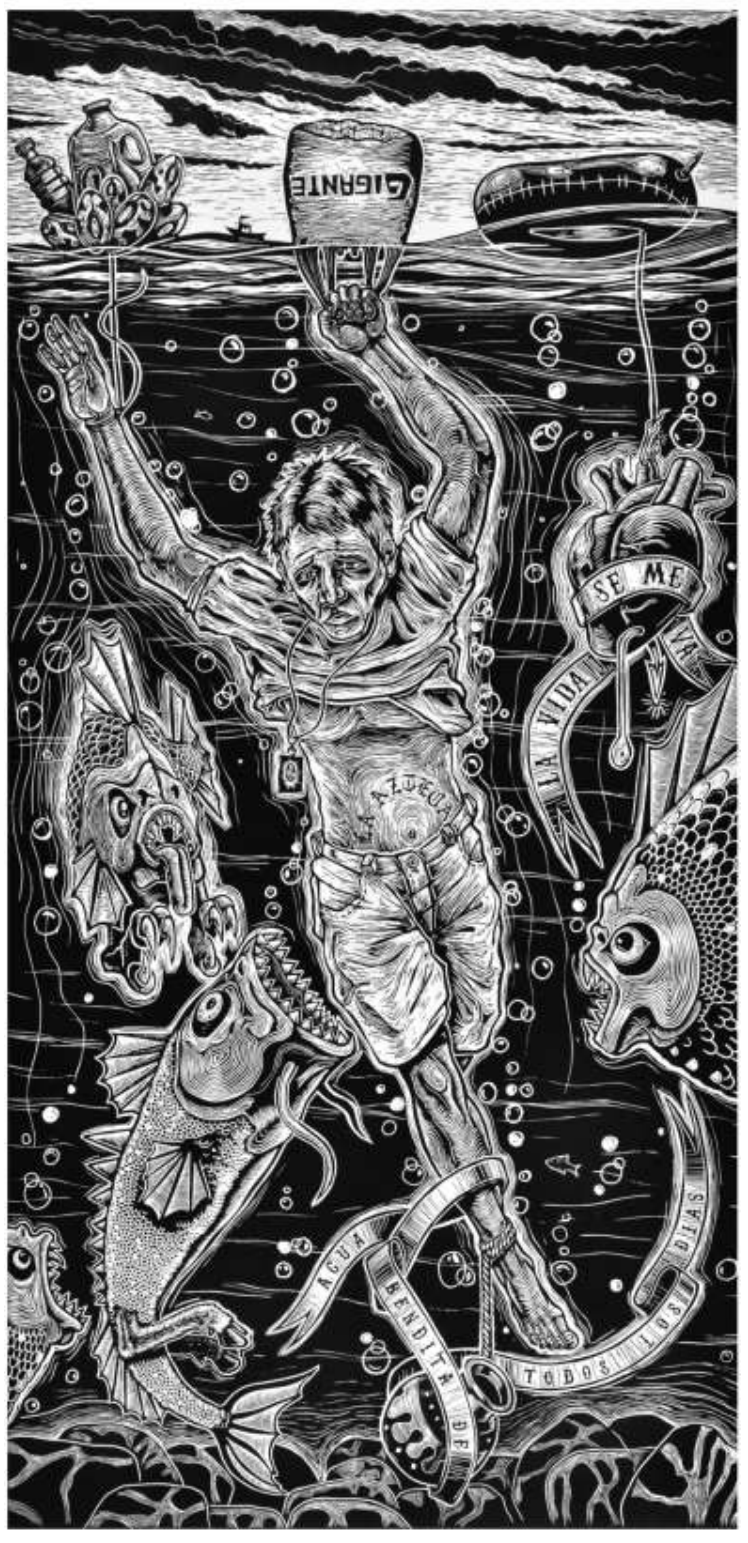
Figure 2 Juan de Dios Mora, Attacked by Fishes , 2009, linocut, 24 ¾ x 12